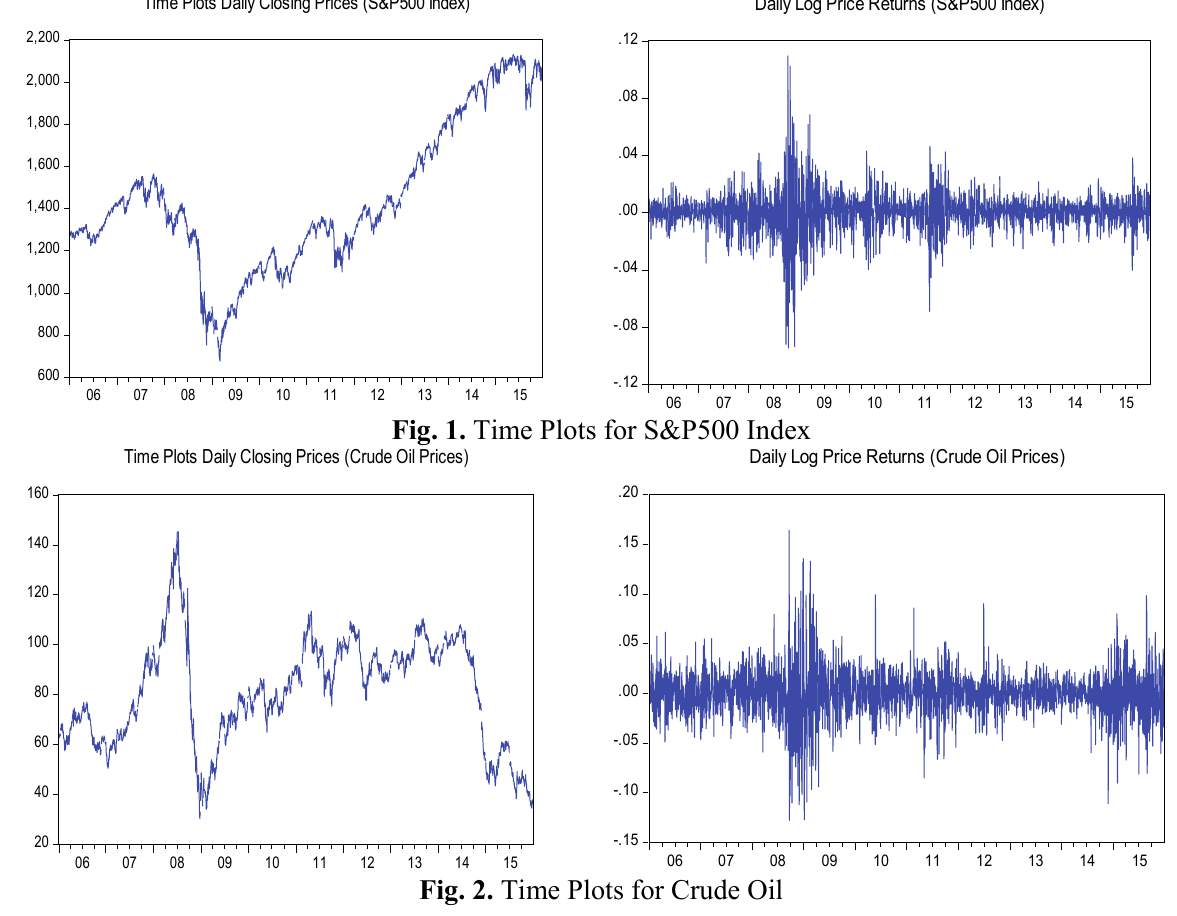
Fig. 2. Time Plots for Crude